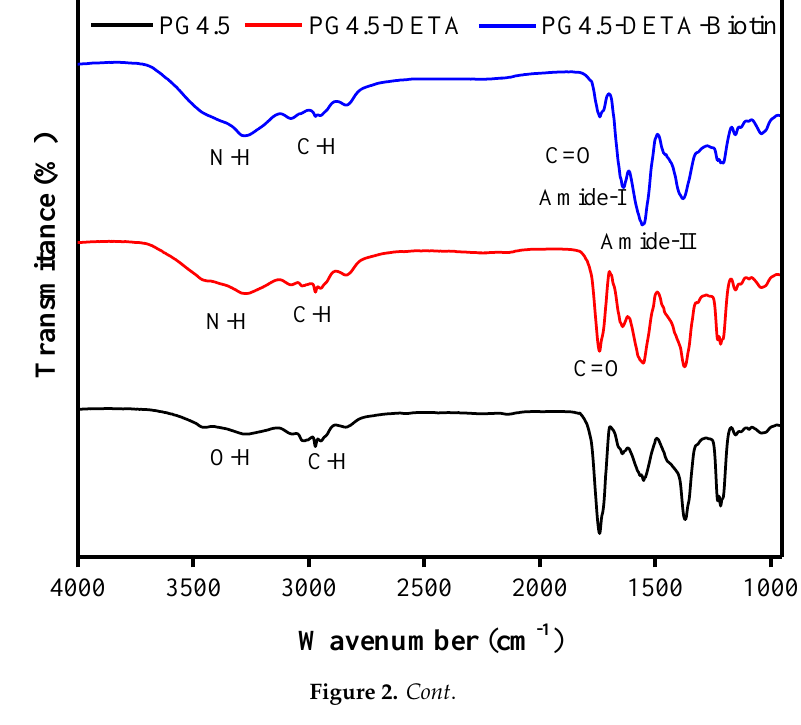
Figure 2. ( A ) FTIR spectra of PG4.5, PG4.5-DETA, and PG4.5-DETA-biotin. ( B ) Raman spectra of PG4.5, PG4.5-DETA, and PG4.5-DETA-biotin. The dendrimer modified with DETA and biotin was characterized by Raman spectroscopy (Figure 2B). The appearance of a new Raman band at 1120 cm −1 ( – CH rock), decreased peak intensity at 885 cm −1 ( – CH twist), and slight shift of the band around 2850 cm −1 ( – CH 2 symmetrical stretch) are most likely due to structural deformation of PG4.5 after conjugation to DETA. In PG4.5-DETA-biotin, the new bands at 820 cm −1 ( – CN ring bending), 1065 cm −1 (S – C stretching), 2849 cm −1 and 2889 cm −1 ( – CH 3 stretching) belong to biotin, whereas the peaks at 965 cm −1 , 1300 cm −1 , 1644 cm −1 (amide), and 2933 cm −1 ( – CH 2 symmetrical stretching) can be attributed to PG4.5-DETA. The reduction in the